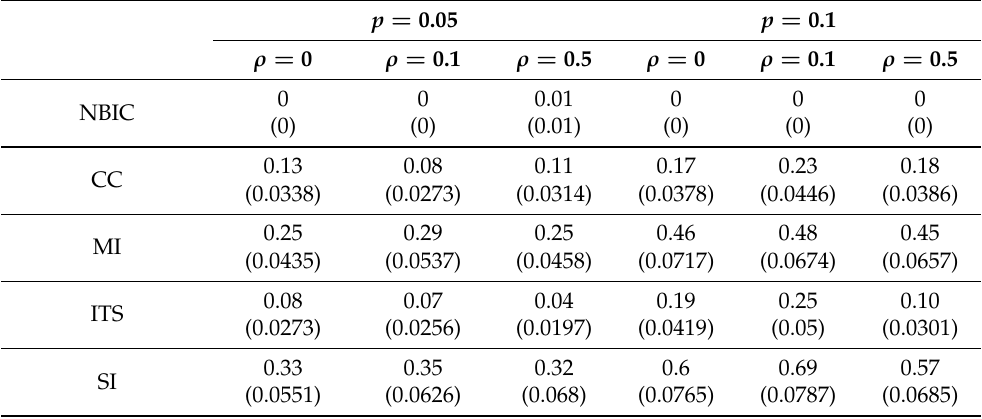
Table A3. Average number of incorrectly included variables, and its standard error over 100 simulated datasets.